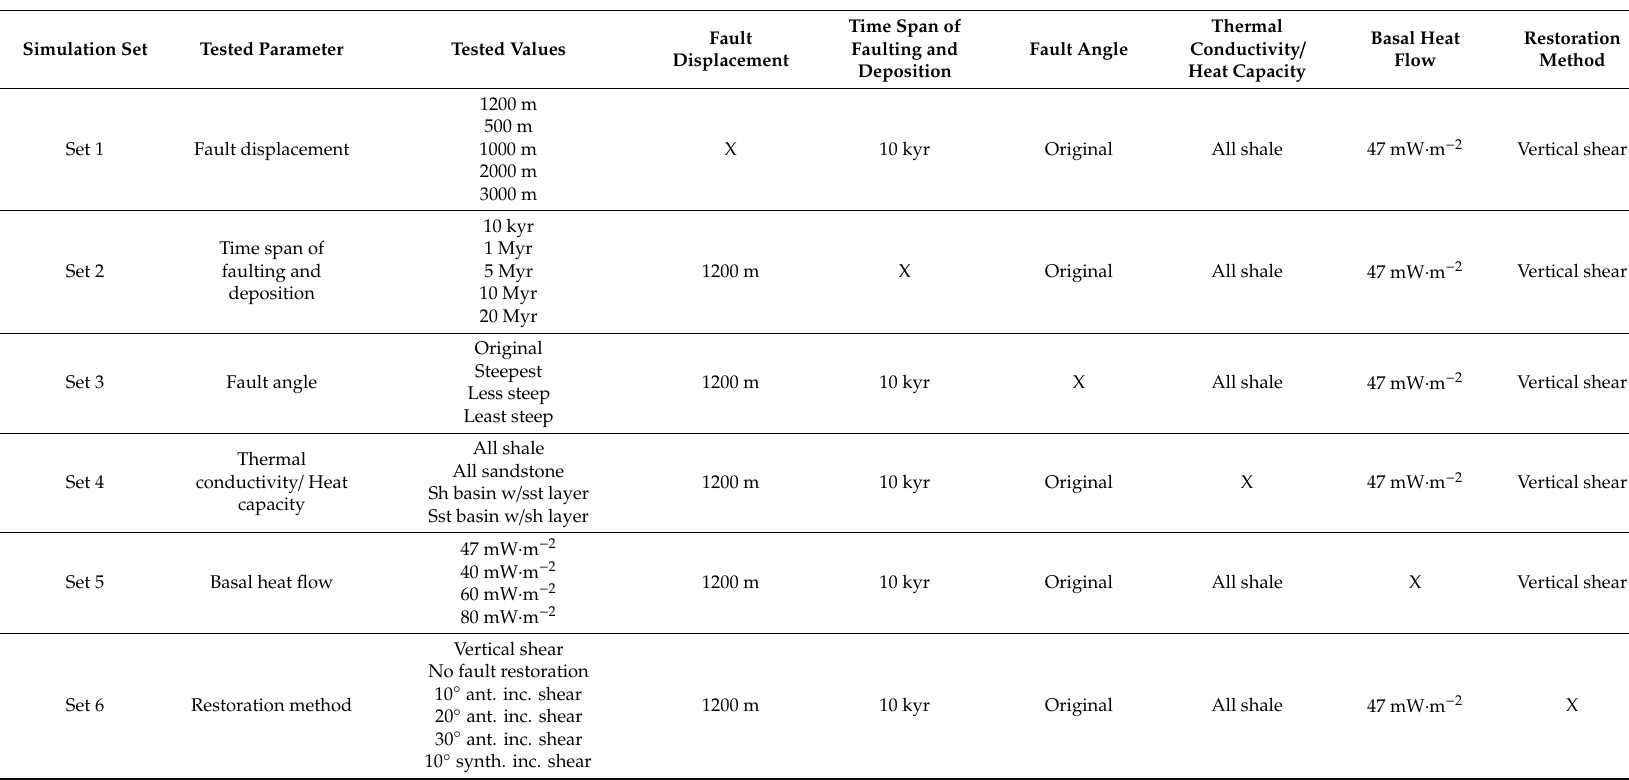
Table 1. Input parameters for the modeling. w = with, sh = shale, sst = sandstone, ant = antithetic, inc = inclined, synth = synthetic, kyr = thousand years. Simulation